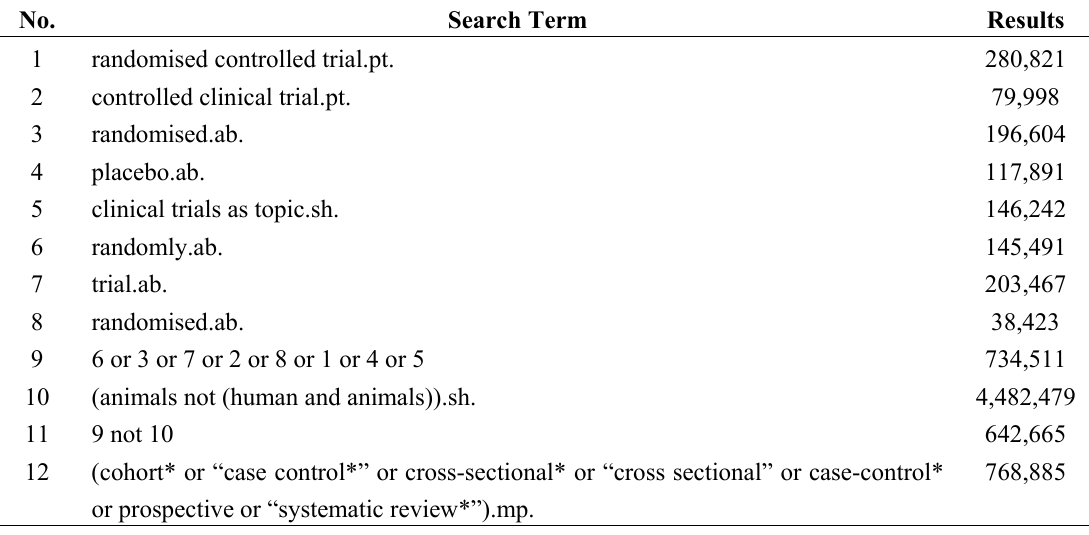
Table 1. Search strategy: MEDLINE February 2010